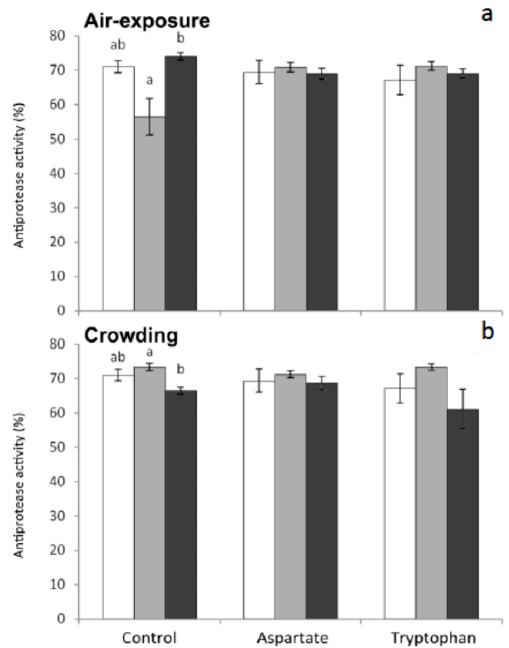
Figure 2. Antiprotease activity (%) in fish stressed by ( a ) air-exposure or ( b ) crowding. Results are shown as mean ± standard error. Different letters indicate significant differences among non-stressed fish (white bars), 1 h post stress (grey bars) and 6 h post stress (black bars). Differences were considered significant when p < 0.05.